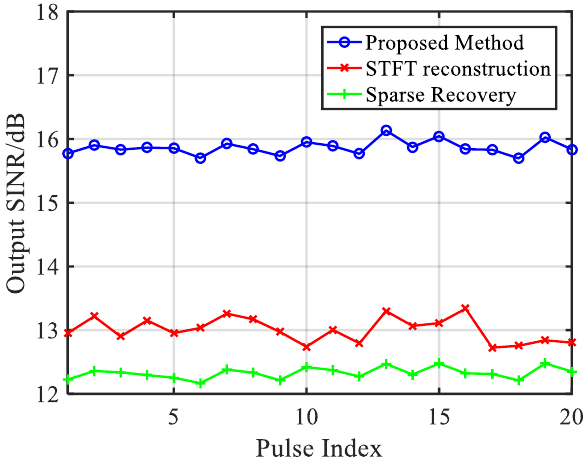
Figure 16. Comparison of SINR improvement of the proposed method with STFT reconstruction and Sparse Recovery using experimental data. Table 3. Average SINR improvement of various methods.